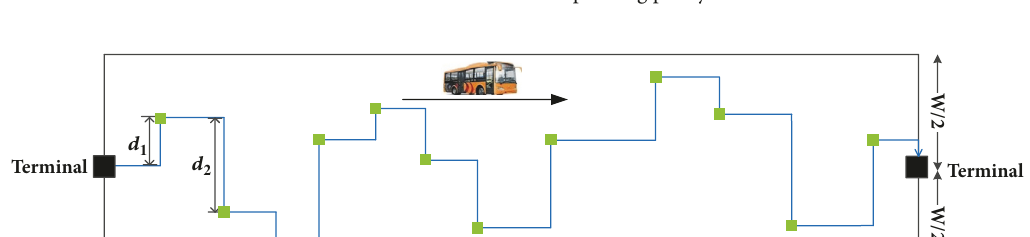
Figure 1: Route deviation operating policy.